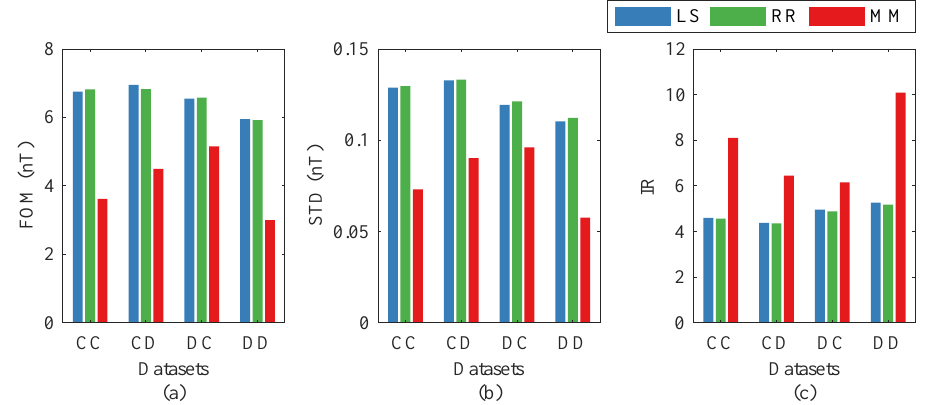
Figure 10. Comparisons between the three compensation methods in non-standard headings: ( a ) figure-of-merit (FOM), ( b ) standard deviation (STD), and ( c ) improvement ratio